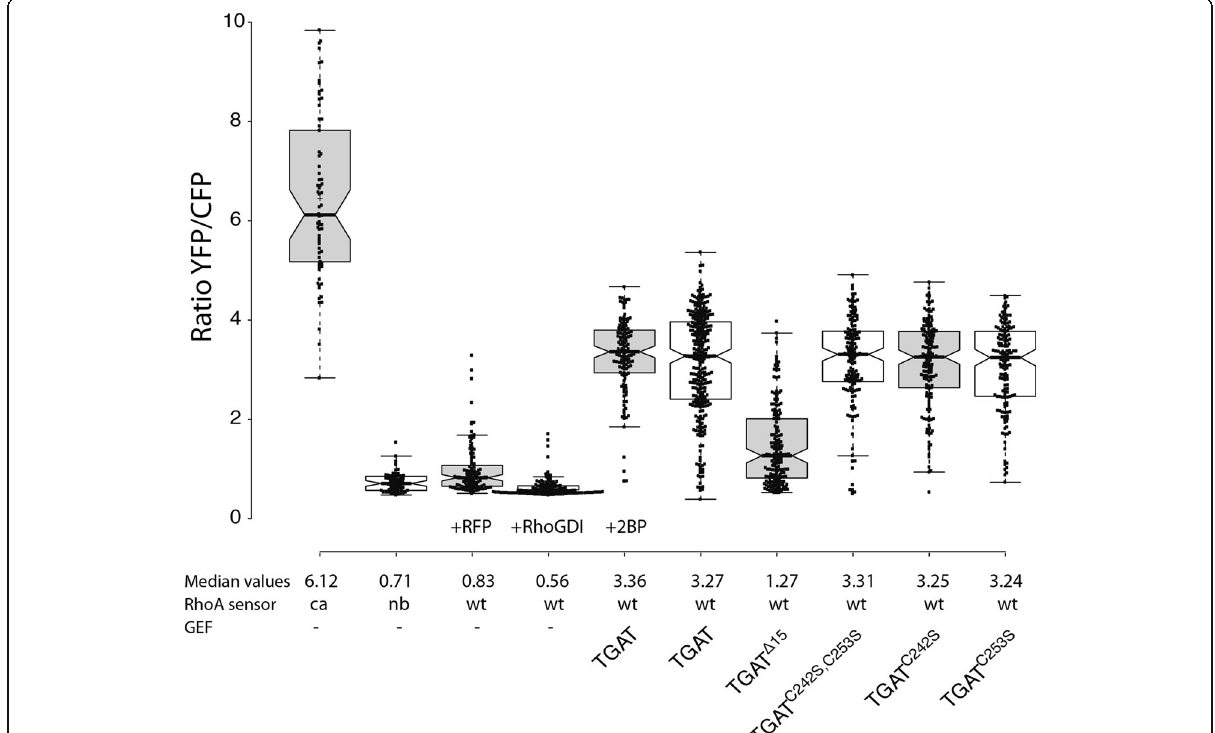
Fig. 4 Basal activation of RhoA by the different TGAT mutants. Boxplot showing the median basal YFP/CFP ratio of the DORA RhoA biosensor in HeLa cells. Cells transfected with the constitutive active (ca, n = 70) or non-binding (nb, n = 62) RhoA biosensor were co-transfected with an empty vector containing only RFP to keep expression levels equal between the different experimental conditions. Wild-type (wt) RhoA biosensor was transfected with an empty vector containing just RFP (control, n = 107), RFP-RhoGDI ( n = 118), RFP-TGAT (+ 2-bromopalmitate ) ( n = 129), RFP-TGAT ( n = 291), RFP-TGAT Δ 15 ( n = 169), RFP-TGAT C242S, C253S ( n = 148), RFP-TGAT C242S ( n = 153) or RFP-TGAT C253S ( n = 150). Boxplot center lines represent the median values; box limits indicate the 25th and 75th percentiles as determined by R software; whiskers extend 1.5 times the interquartile range from the 25th and 75th percentiles; data points from individual cells are plotted as